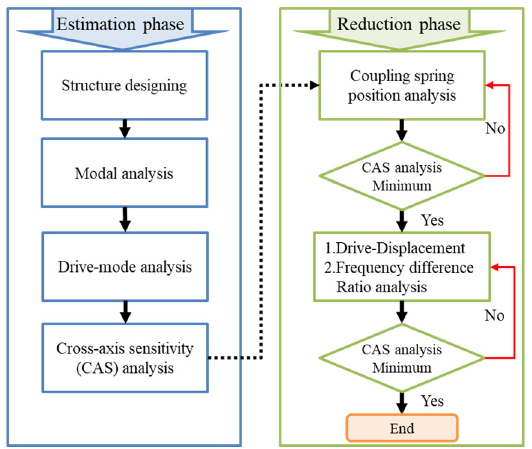
Figure 6. Proposed Design Approach Workflow for Cross-Axis Sensitivity Analysis for the Designed Gyroscope.